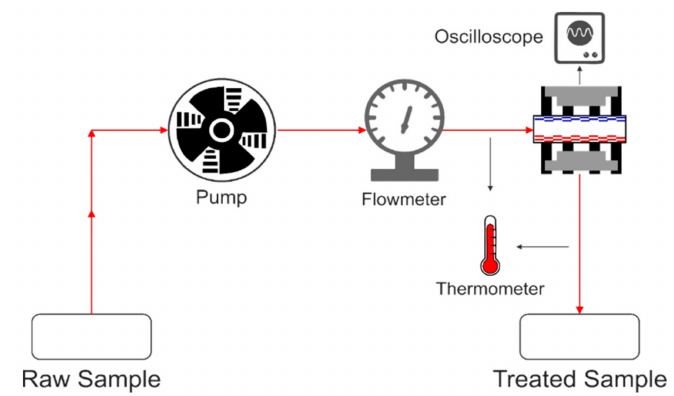
Figure 3. PEF (pulsed electric field) continuous extraction